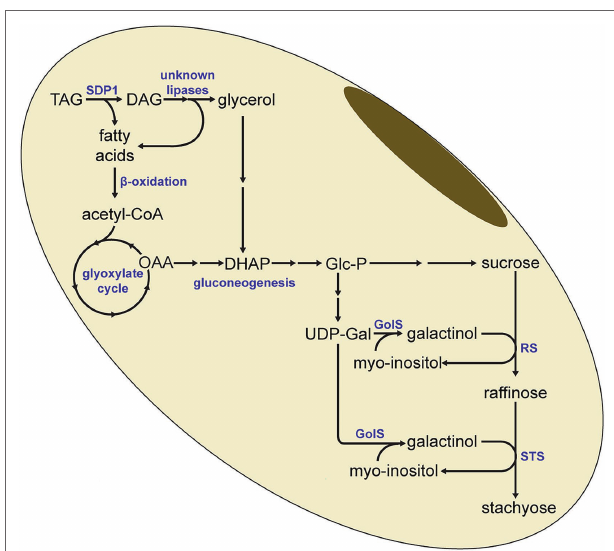
FIGURE 8 | Model for the redistribution of carbon from triacylglycerol to raffinose and stachyose. SDP1-mediated hydrolysis of triacylglycerol (TAG) yields fatty acids, which can be converted to glucose-phosphate (Glc-P) through β -oxidation, the glyoxylate cycle and gluconeogenesis. Glc-P is then synthesized to UDP-Galactose (UDP-Gal) and sucrose, the precursors for raffinose and stachyose. It is possible for diacylglycerol (DAG) to be further hydrolyzed to provide additional fatty acids, as well as glycerol, for conversion to glucose. In this simplified pathway, not all enzymatic steps or intermediate metabolites are indicated. DHAP, dihydroxyacetone phosphate; GolS, Galactinol Synthase; OAA, oxaloacetate; RS, raffinose synthase; STS, stachyose